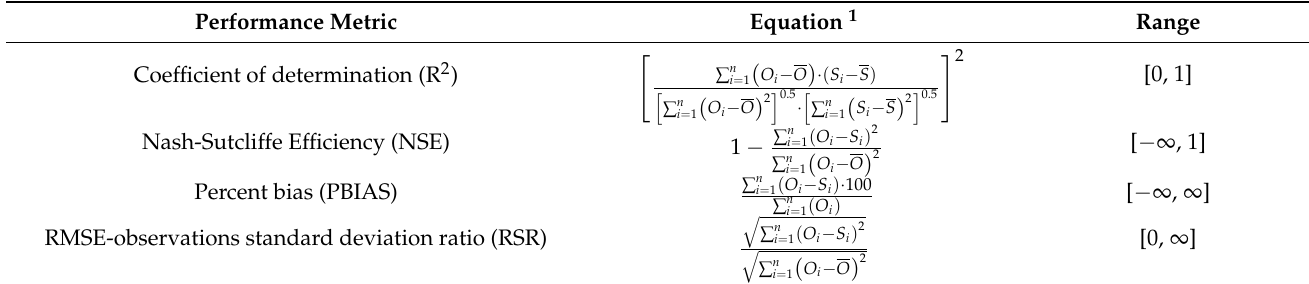
Table 5. Model performance metrics.